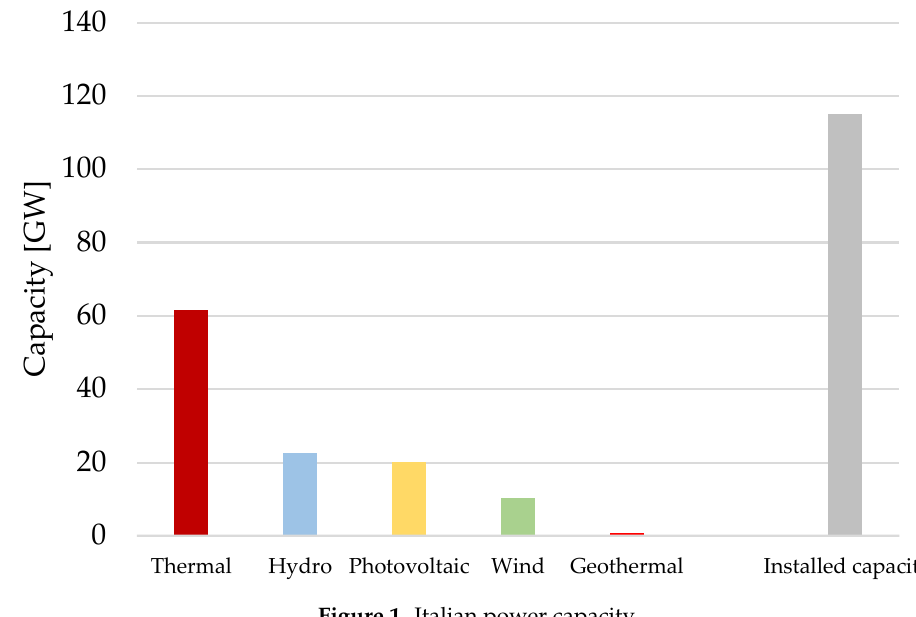
Figure 1. Italian power capacity.